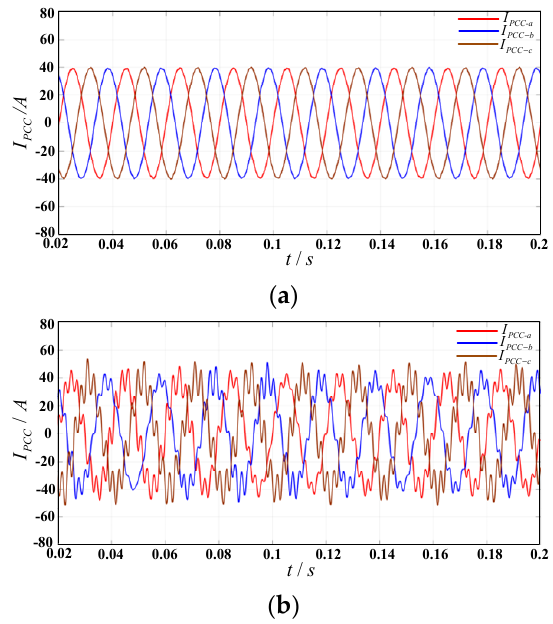
Figure 16. Simulation result of current waveform at PCC with and without parallel compensation capacitors. ( a ) Without parallel compensation capacitors; ( b ) With parallel compensation capacitors.